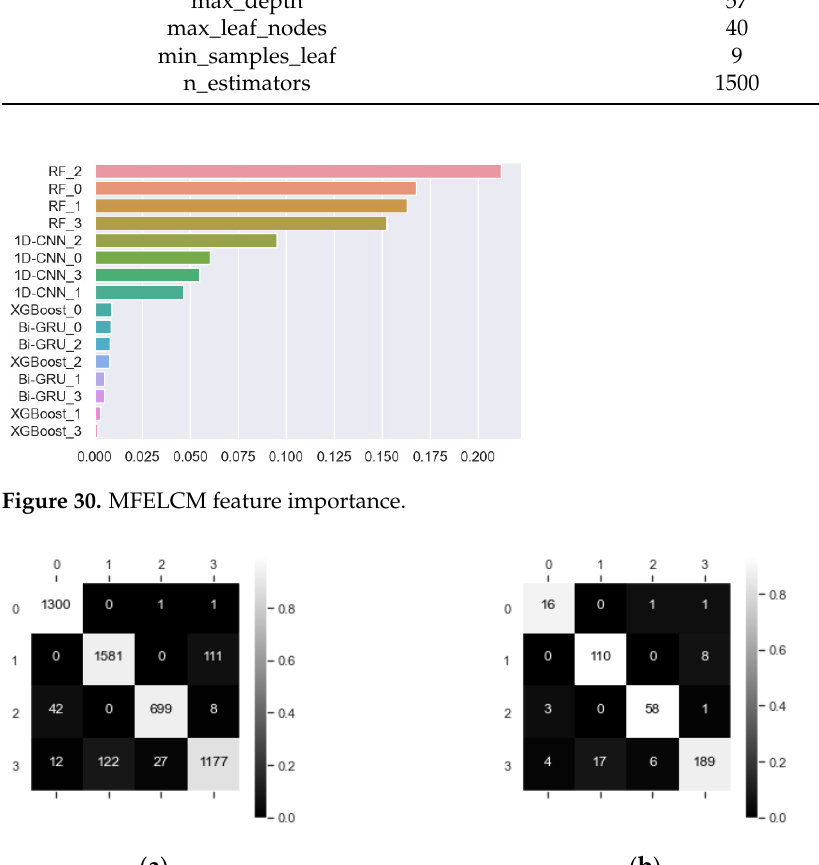
Table 14. Parameters of Random Forest2 (in MFELCM1).